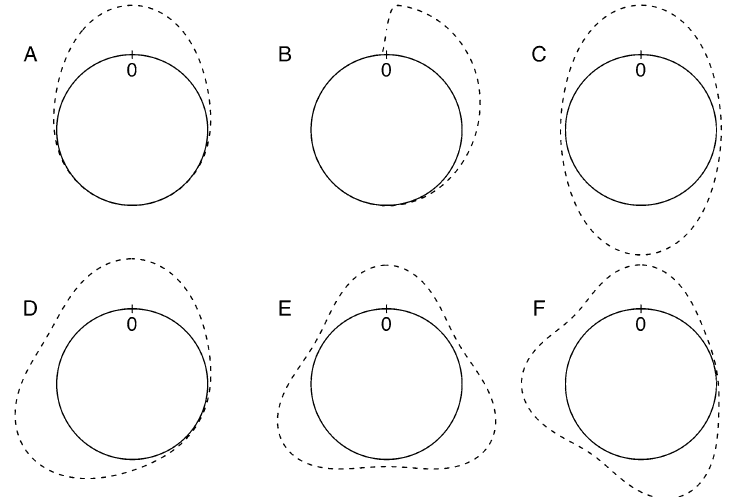
Figure 1. Densities for distribution types used in this paper: unimodal von Mises ( A ), unimodal wrapped skew-normal ( B ), axial von Mises ( C ), asymmetrical bimodal von Mises ( D ), symmetrical trimodal von Mises ( E ), asymmetrical trimodal von Mises ( F